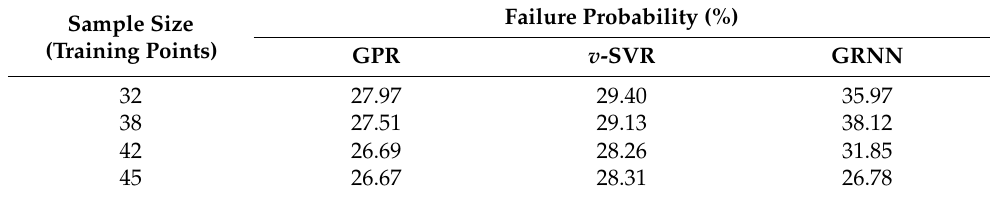
Figure 8. Taylor diagram of training and testing obtained from WOA-GPR, v -SVR, and GRNN. Table 5. Model failure probability estimated from GPR, v -SVR, and GRNN methods in Case 1.